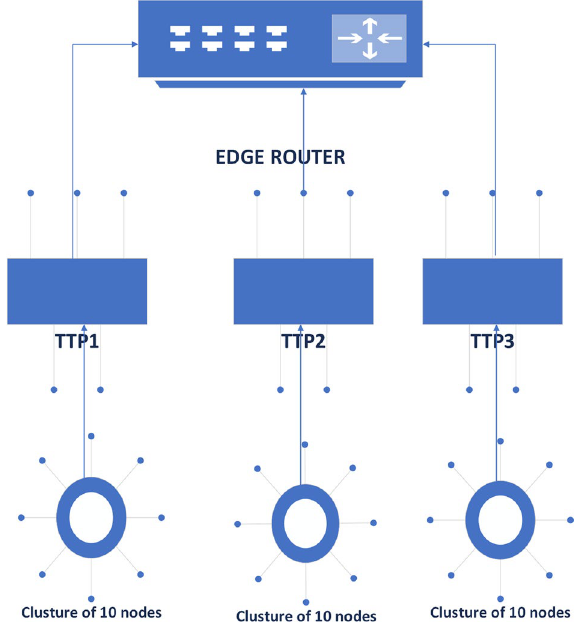
Fig. 8 Modified smart home communication